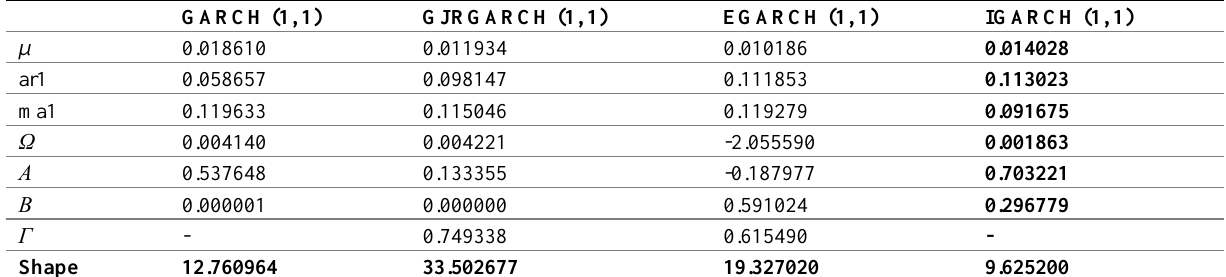
Table 3: Estimated parameters - student t distribution